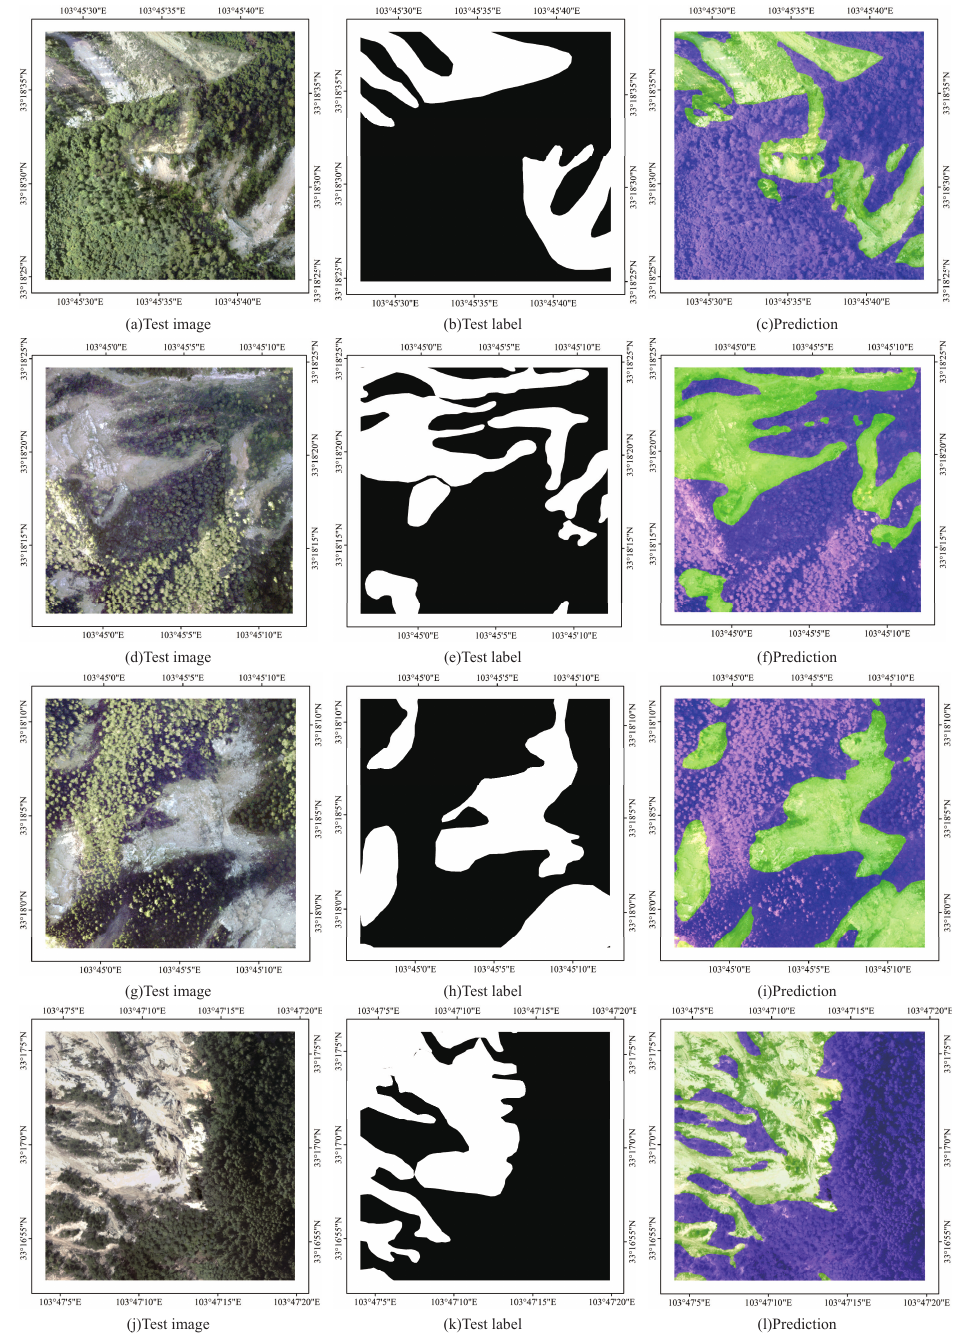
Figure 5. Visualization results of image